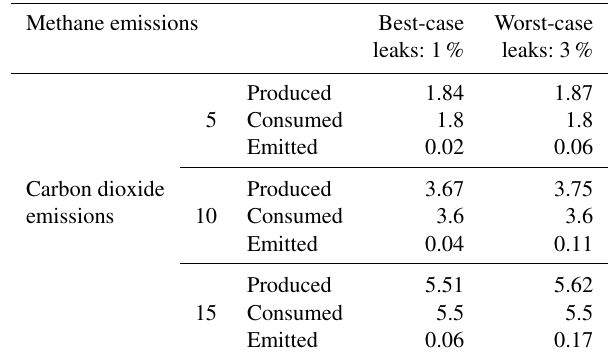
Table 4. Methane emissions (in kg) associated with different levels of carbon dioxide emissions (in kg) from fossil fuel technologies and for best- and worst-case leak rates. (Note: the values presented in the table have been